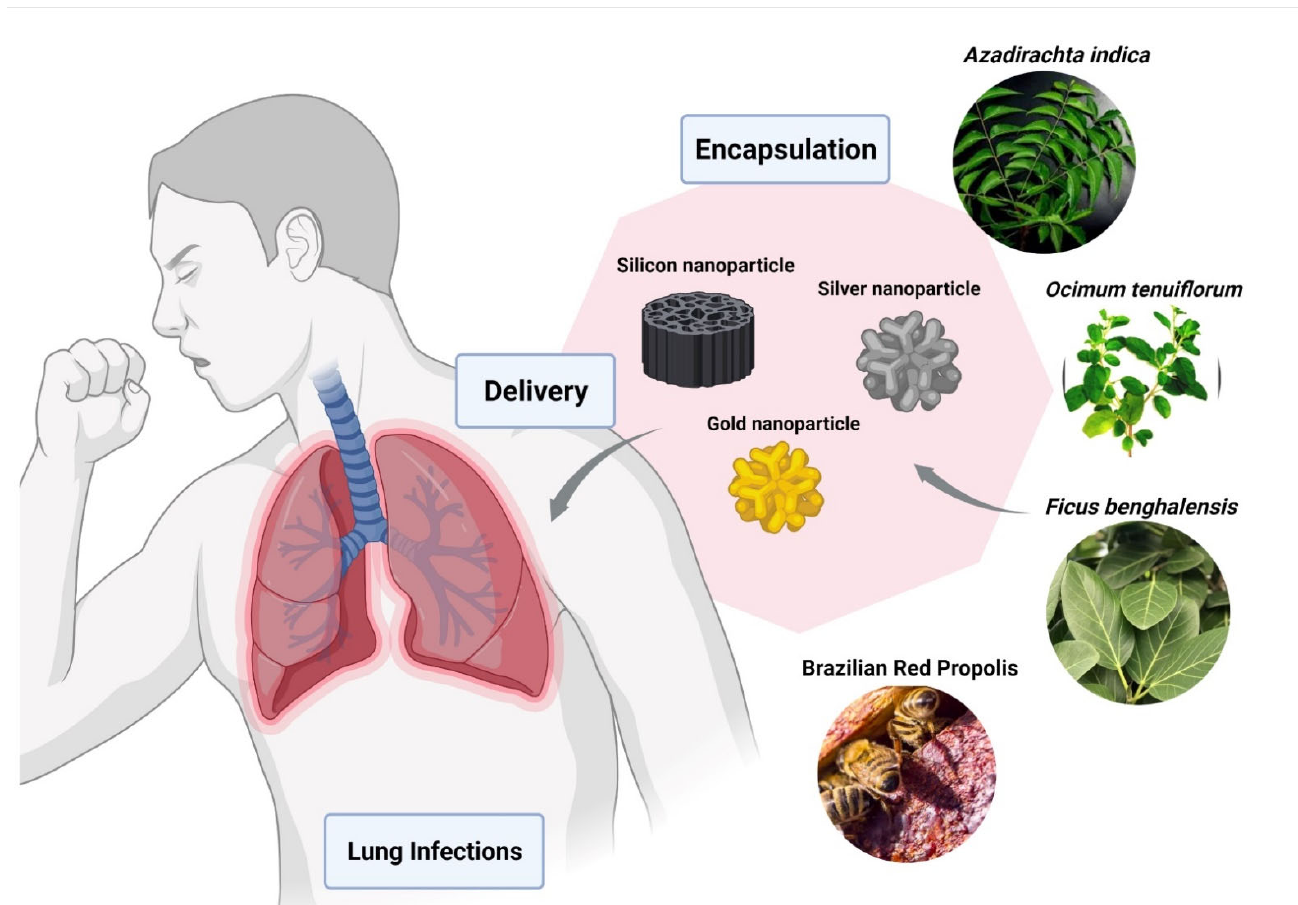
Figure 4. Encapsulation of bio ‐ active compounds from various herbal extracts with silver, silicon, or gold nanoparticles to improve delivery in lungs and to prevent pulmonary disorders. The figure was made with www.biorender.com (access date: 12 January 2022).